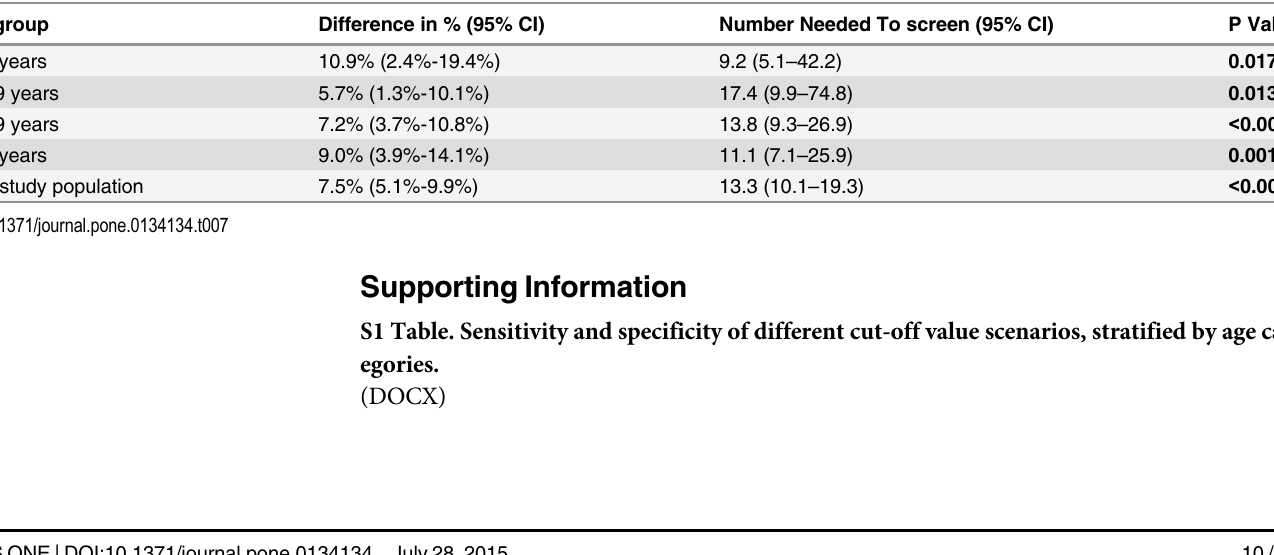
Table 7. Reduction of number of biopsies with the “ new ” PSA cut offs stratified by